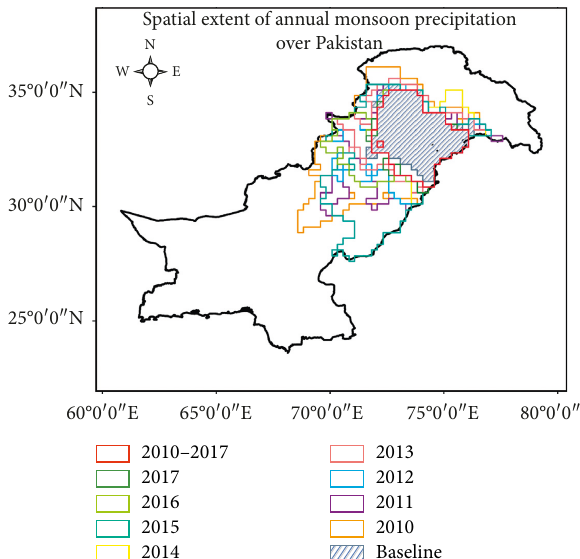
4mm/day. A shift towards south-east and east can be observed in ≥